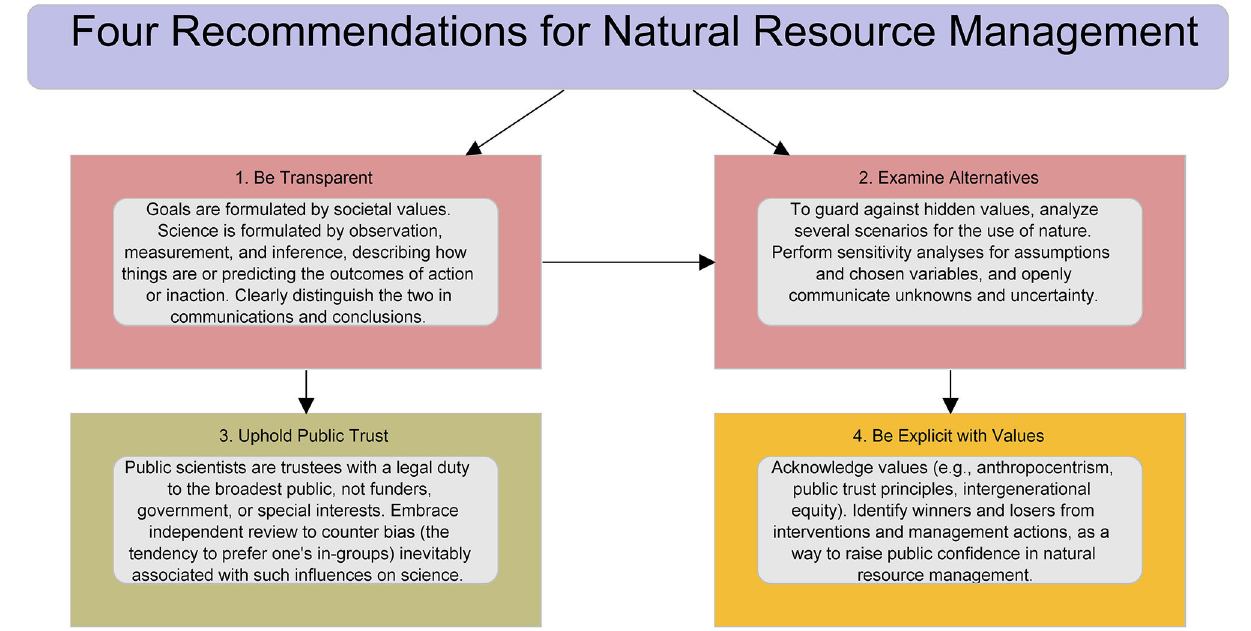
FIGURE 3 | Recommendations for where the science begins and ends in NRM. Pink boxes are aimed at the dialogue between science and public policy, the orange box is aimed at policy-makers, and the green box is aimed at scientists. Arrows indicate cause and effect relationships, e.g., being transparent and examining alternatives will help scientists to uphold the public trust although not sufficient by